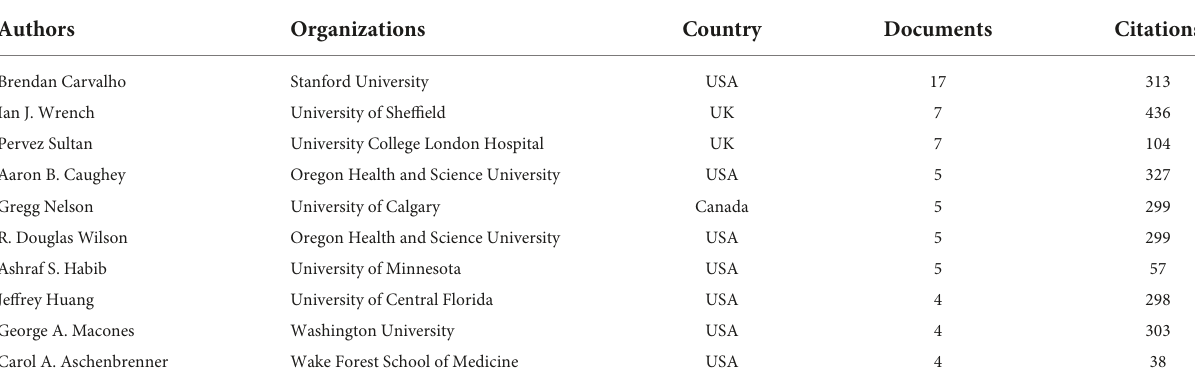
TABLE 4 Top 10 active authors with most